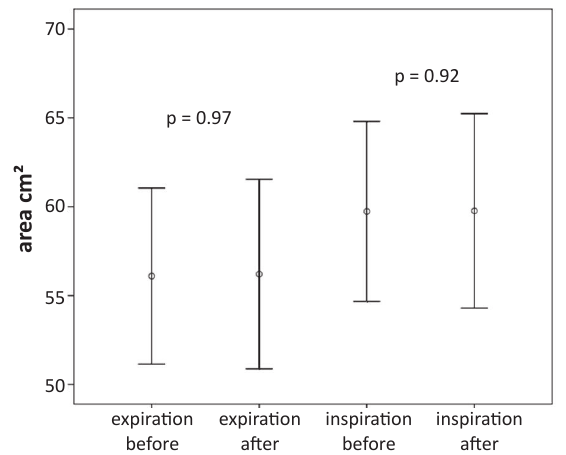
Figure 2 - Means comparison of thoracoabdominal area, before and after expiratory flow increase technique through- out respiratory cycle (inspiration and expiration). The figure shows that there is no significant statistical difference (p < 0.05 and paired